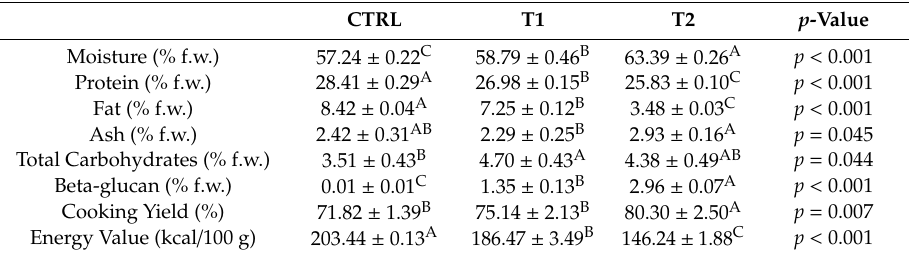
Table 2. Chemical composition, cooking yield and energy value of the cooked beef burger without fat substitution (CTRL) and at 50% (T1) and 100% (T2) fat substitution with an oat-hull-based gel. CTRL T1 T2 p -Value Moisture (% f.w.) 57.24 ± 0.22 C 58.79 ± 0.46 B 63.39 ± 0.26 A p < 0.001 Protein (% f.w.) 28.41 ± 0.29 A 26.98 ± 0.15 B 25.83 ± 0.10 C p < 0.001 Fat (% f.w.) 8.42 ± 0.04 A 7.25 ± 0.12 B 3.48 ± 0.03 C p < 0.001 Ash (% f.w.) 2.42 ± 0.31 AB 2.29 ± 0.25 B 2.93 ± 0.16 A p = 0.045 Total Carbohydrates (% f.w.) 3.51 ± 0.43 B 4.70 ± 0.43 A 4.38 ± 0.49 AB p = 0.044 Beta-glucan (% f.w.) 0.01 ± 0.01 C 1.35 ± 0.13 B 2.96 ± 0.07 A p < 0.001 Cooking Yield (%) 71.82 ± 1.39 B 75.14 ± 2.13 B 80.30 ± 2.50 A p = 0.007 Energy Value (kcal / 100 g) 203.44 ± 0.13 A 186.47 ± 3.49 B 146.24 ± 1.88 C p <